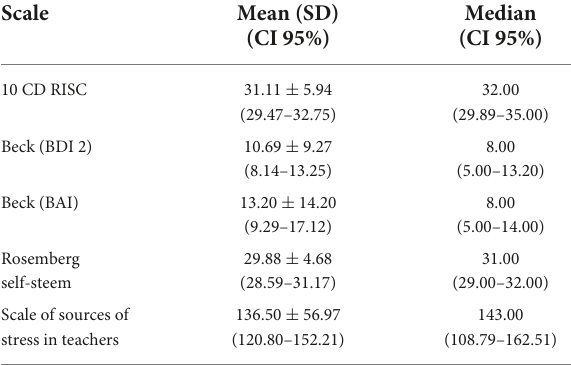
TABLE 2 Descriptive data based on different assessment